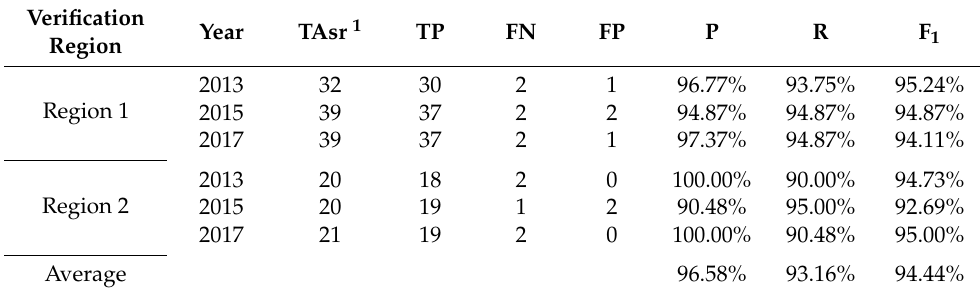
Figure 8. Target recognition verification: Region1 is located in the northern part of the Pearl River Mouth Basin and Region2 is located in the southern part of the Zengmu Basin. Green circles indicate correctly recognized targets, yellow circles indicate omissive targets, and red circles indicate incorrectly recognized targets. The red arrows indicate the Global Gas Flaring Product released by the Earth Observations Group. Table 1. Precision